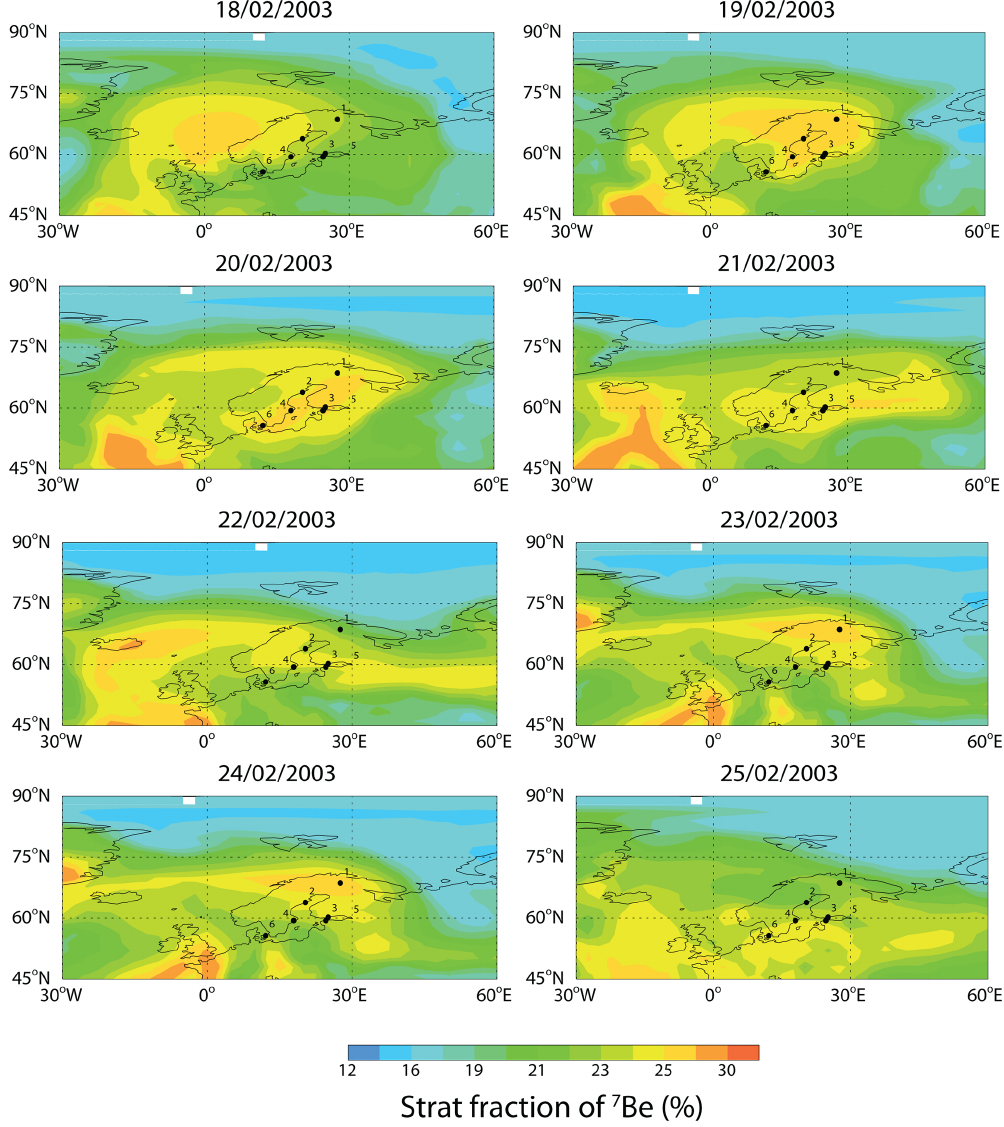
Figure 14. Simulated daily mean fraction of 7 Be originating in the stratosphere (%) at 940hPa. The dots indicate the locations of the sampling sites: 1 = Ivalo, 2 = Umeå, 3 = Helsinki, 4 = Kista, 5 = Harku, 6 =